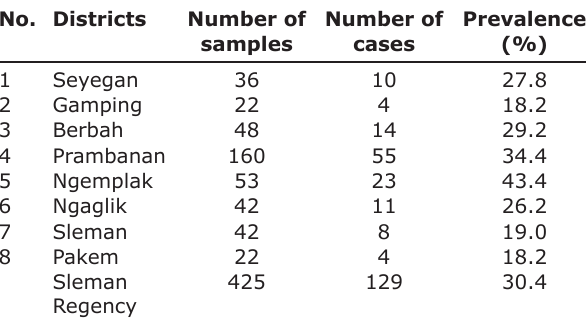
Table-1: The prevalence of repeat breeding in beef cattle in Sleman Regency,